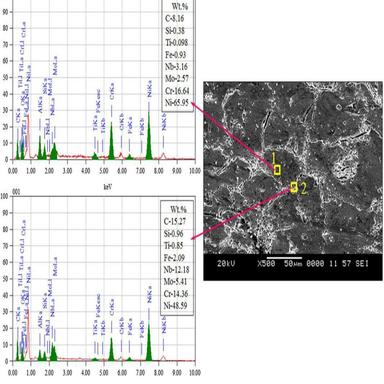
SEM micrograph and EDS analysis in fusion zone of Inconel-625 specimen welded at 900 W.